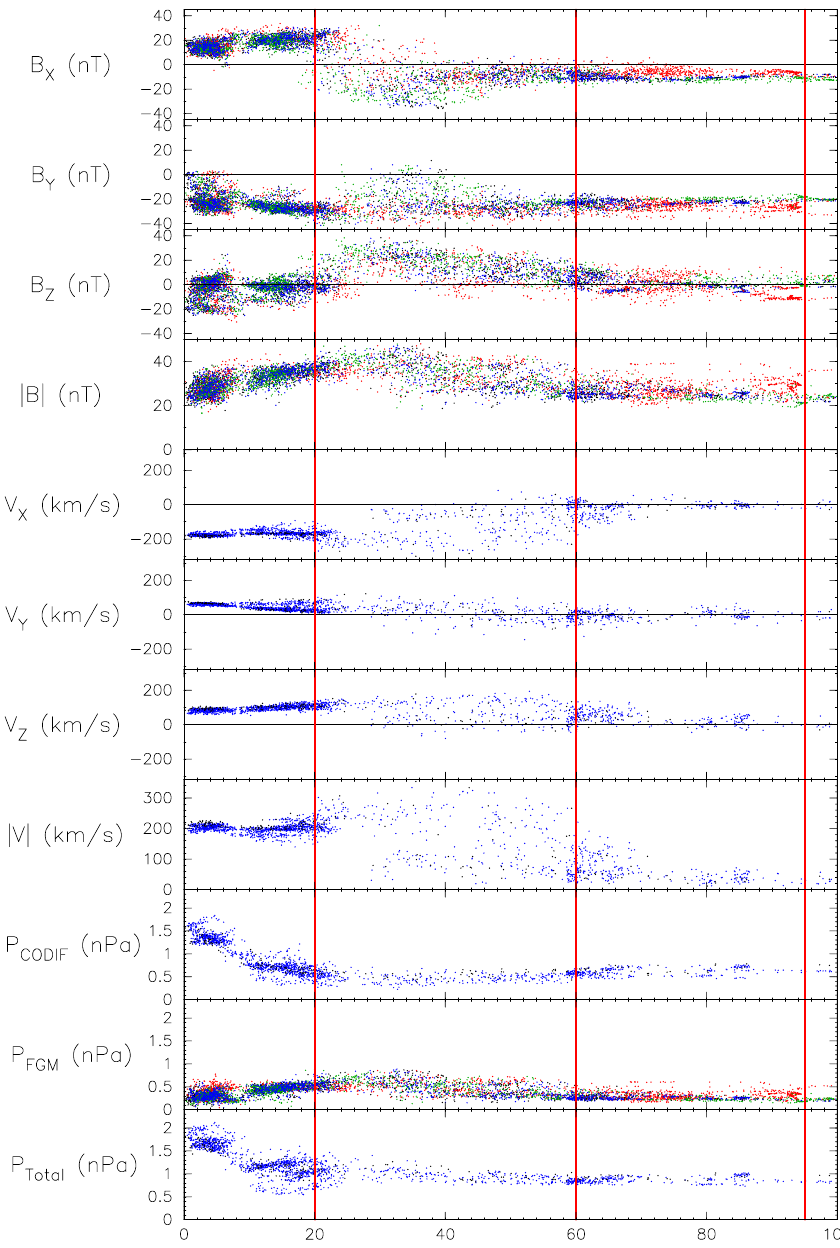
Fig. 5. The magnetic field, proton velocity and gas, magnetic and total pressure reordered by transition parameter. The proton velocities and pressure are derived from CODIF ground moments which have undergone a dead-time correction to improve their accuracy in the magnetosheath. A period of magnetosheath magnetic field reorientation (11:15 to 11:30 UT on Clusters 1, 3 and 4; 11:16 to 11:32 UT on Cluster 2) has been removed from the top four panels. The boundaries between the magnetosheath, outer and inner boundary layers and magnetosphere are indicated by vertical